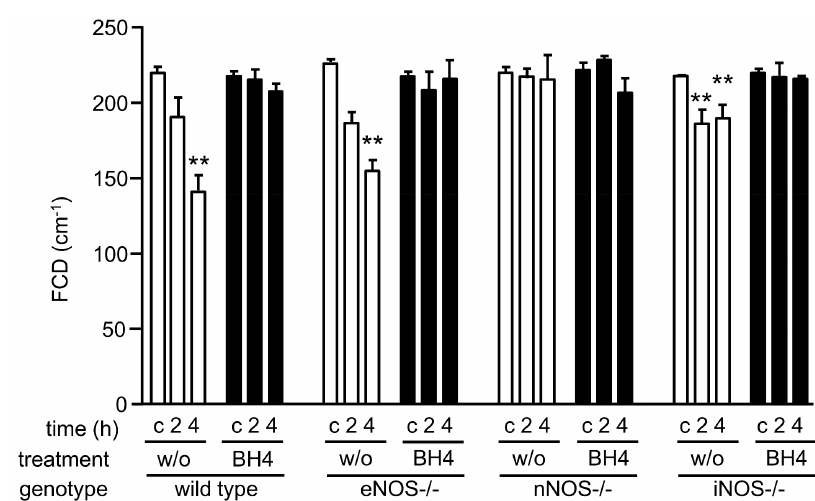
Figure 2. Functional capillary density of pancreata in dependence of treatment, donor type and time point. Pancreata were taken from BH4-treated or untreated donors with the indicated genotypes, subjected to ischemia, and transplanted to wt recipients of the same background as the knockouts (n=5 per group). FCD was evaluated by digital analysis of CIVFM pictures taken at the indicated time points. c: non-transplanted controls, 2: grafts following 2 h reperfusion, 4: grafts following 4 h reperfusion. Mean values of 5 animals per group + / 2 SEM are shown. w/o: untreated. Asterisks indicate significant differences between reperfusion time point and the respective non-transplanted control: * p , 0.05, ** p , 0.01, *** p , 0.001.